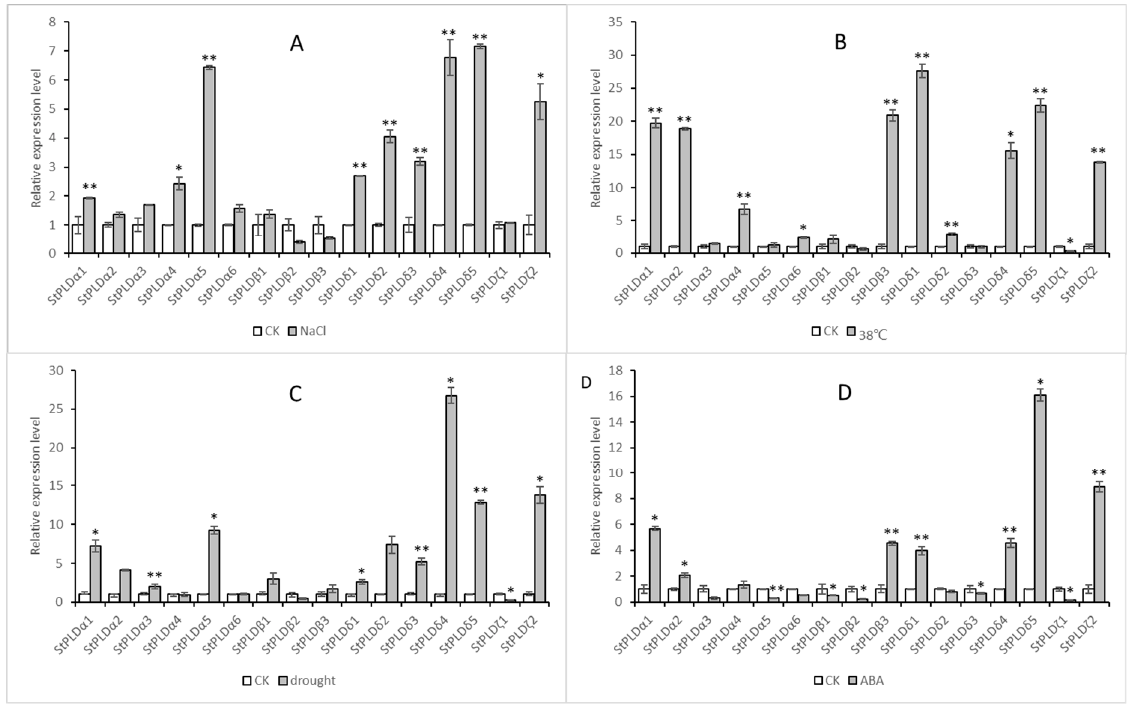
Figure 9. Differential expression of the StPLD gene family in response to abiotic stress and hormone induction. ( A ) Relative expression level under NaCl treatment. ( B ) Relative expression level at 38 °C. ( C ) Relative expression level under drought treatment. ( D ) Relative expression level under ABA treatment. (* t-test p -value < 0.05, ** t-test p -value < 0.01).